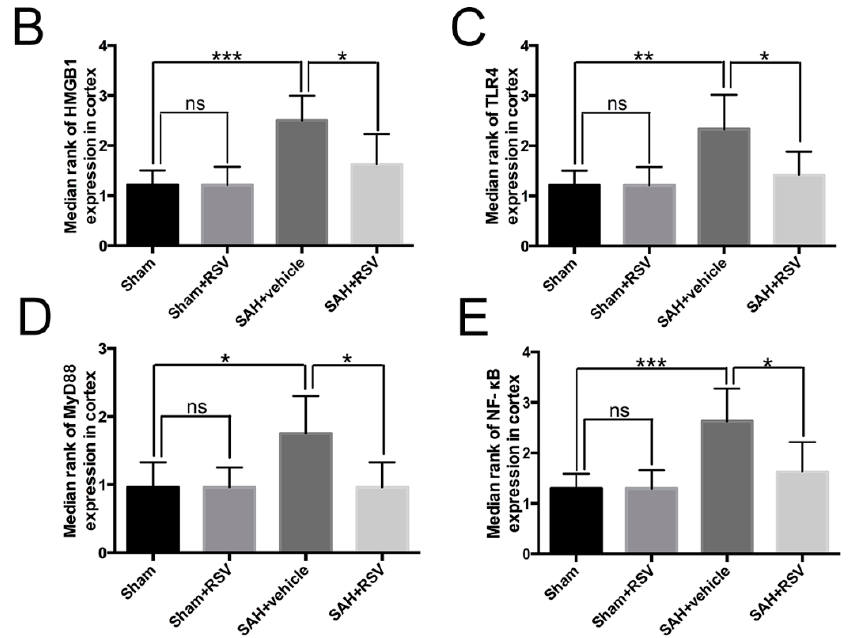
Figure 3. Effects of resveratrol (RSV) on high-mobility group box 1 (HMGB1), toll-like receptor 4 (TLR4), myeloid differentiation factor 88 (MyD88), and nuclear factor- κ B (NF- κ B) distribution at 24 h after subarachnoid hemorrhage (SAH). ( A – E ) RSV treatment could significantly reduce the immunoreactivity of HMGB1, TLR4, MyD88, and NF- κ B in the cerebral cortex when compared with SAH + vehicle group. Bars represent the mean ± SD. *** p < 0.001, ** p < 0.01, * p < 0.05, and ns means non-significant. Scale Bars = 50 μ m.